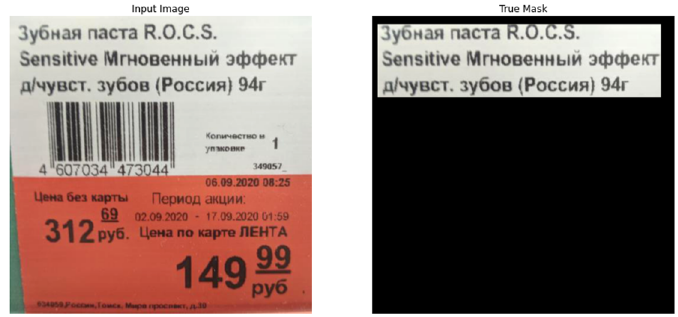
Figure 3. An example of the layout of the description segment.